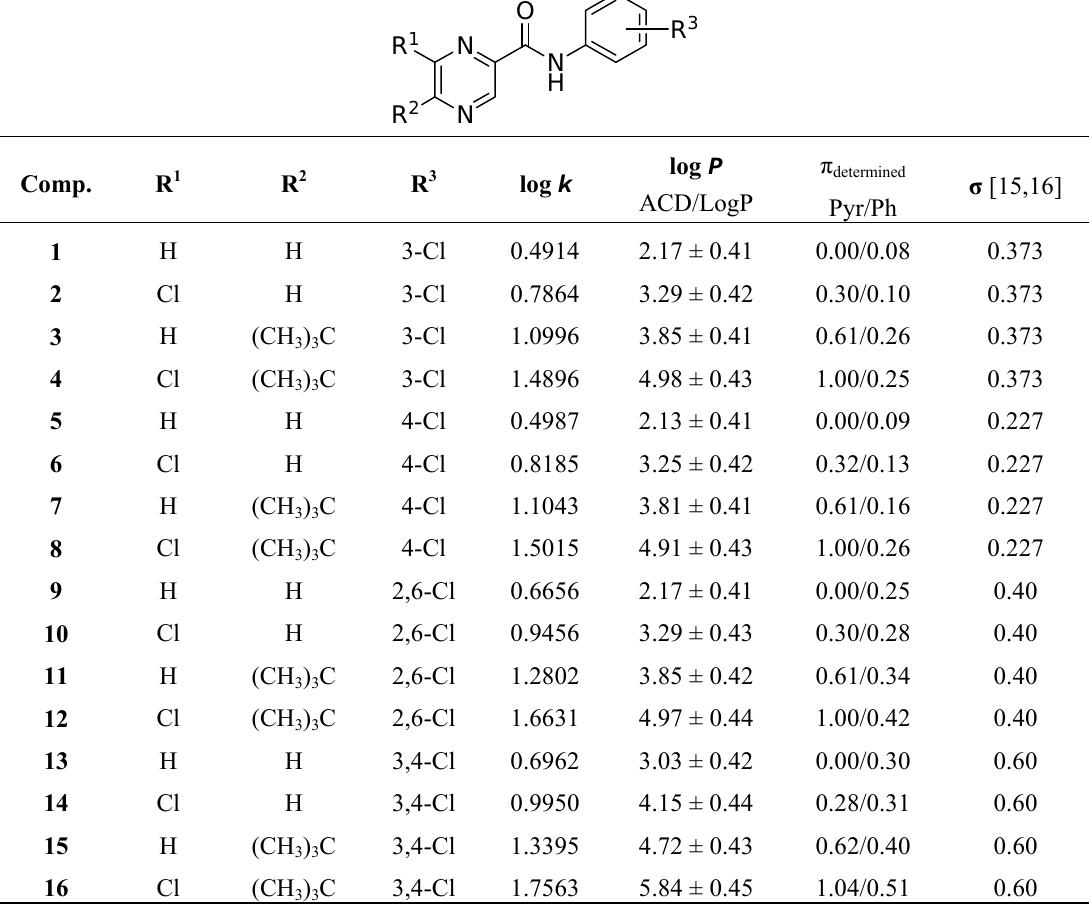
Table 1. Comparison of the calculated lipophilicity (log P ) with the determined log k values of the discussed pyrazinecarboxamides 1 - 16 , as well as the determined distributive parameters π calculated from log k